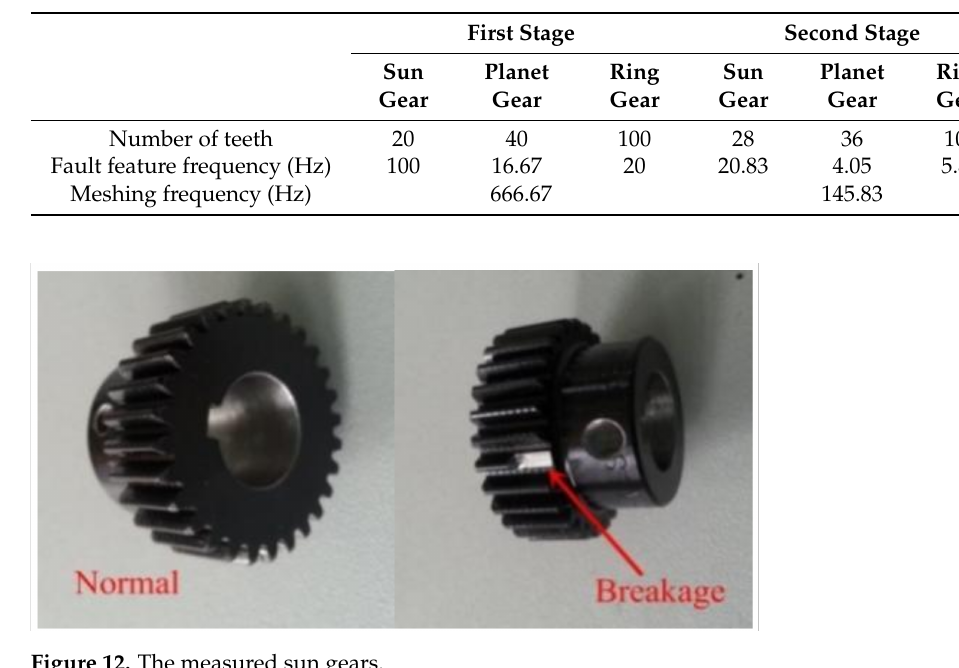
Table 1. Basic parameters of two-stage planetary gearbox.